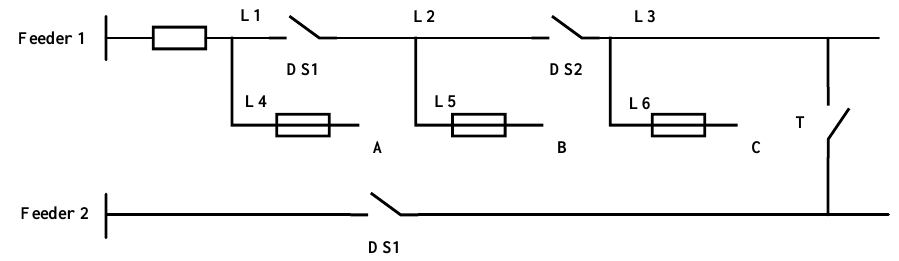
Figure 5. Typical power distribution system structure.